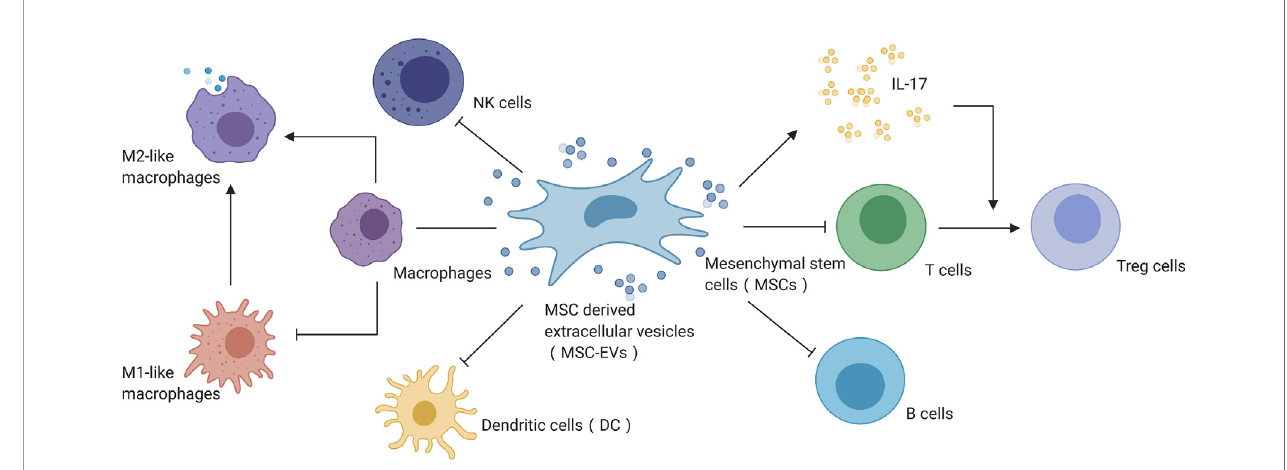
FIGURE 3 | MSC-EVs mediate immune regulation in AKI. Created